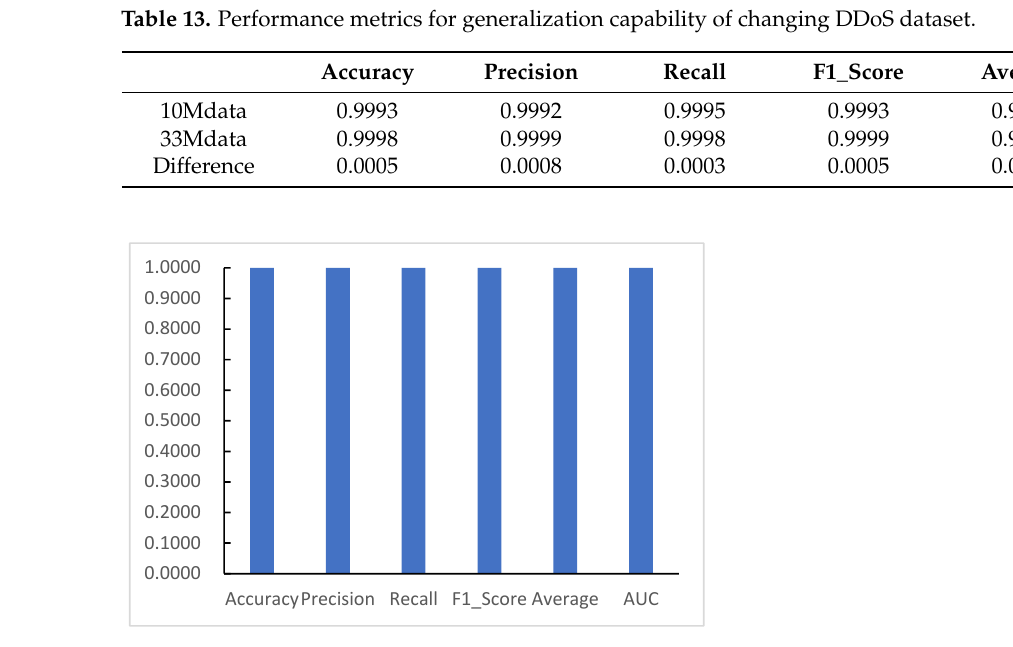
Figure 29. Performance demonstration with changing DDoS dataset.